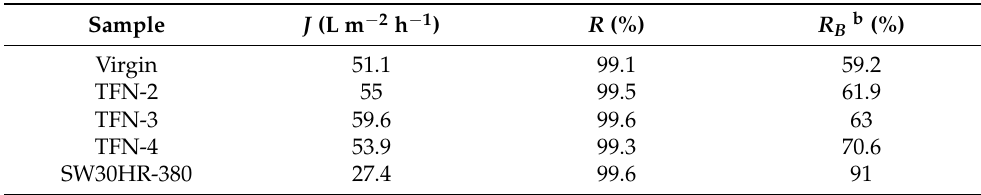
Figure 10. Effects of ODA@GO loading on the flux and salt rejections of the RO membranes under pure water, brackish water desalination, and seawater desalination tests. Table 3. Transport properties of RO membranes in this work and the SWRO commercial membrane at seawater desalination condition a .